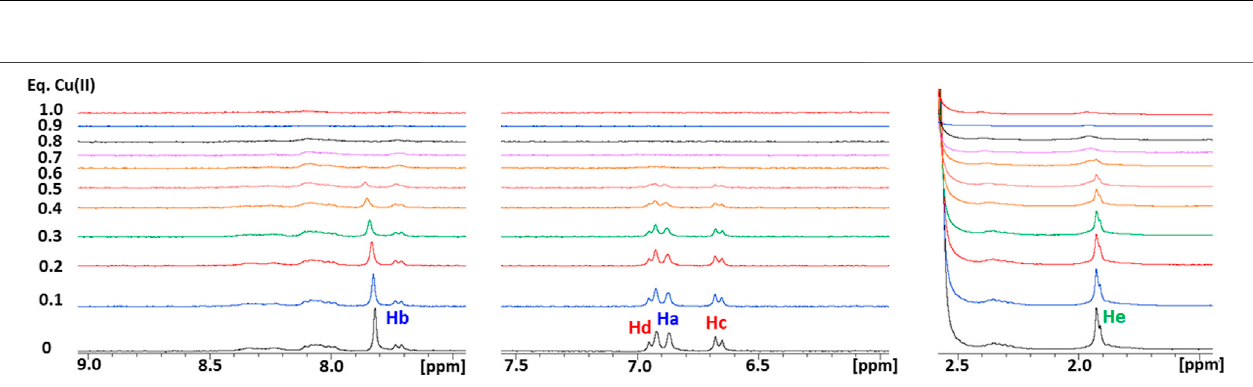
FIGURE5 | Overlay ofthree regions of 1D 1 H NMR spectra ofCtr1 1-14 in 10 mM MES(pH 7)at different Ag(I):peptideratios. Proton assignment scheme asshown in Figure 1C .